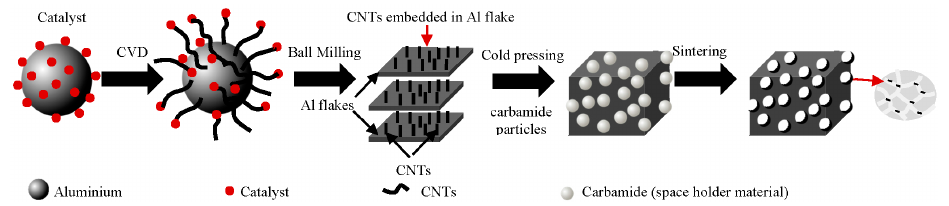
Figure 12. Schematic diagram of the procedures used to fabricate CNT/Al [141].